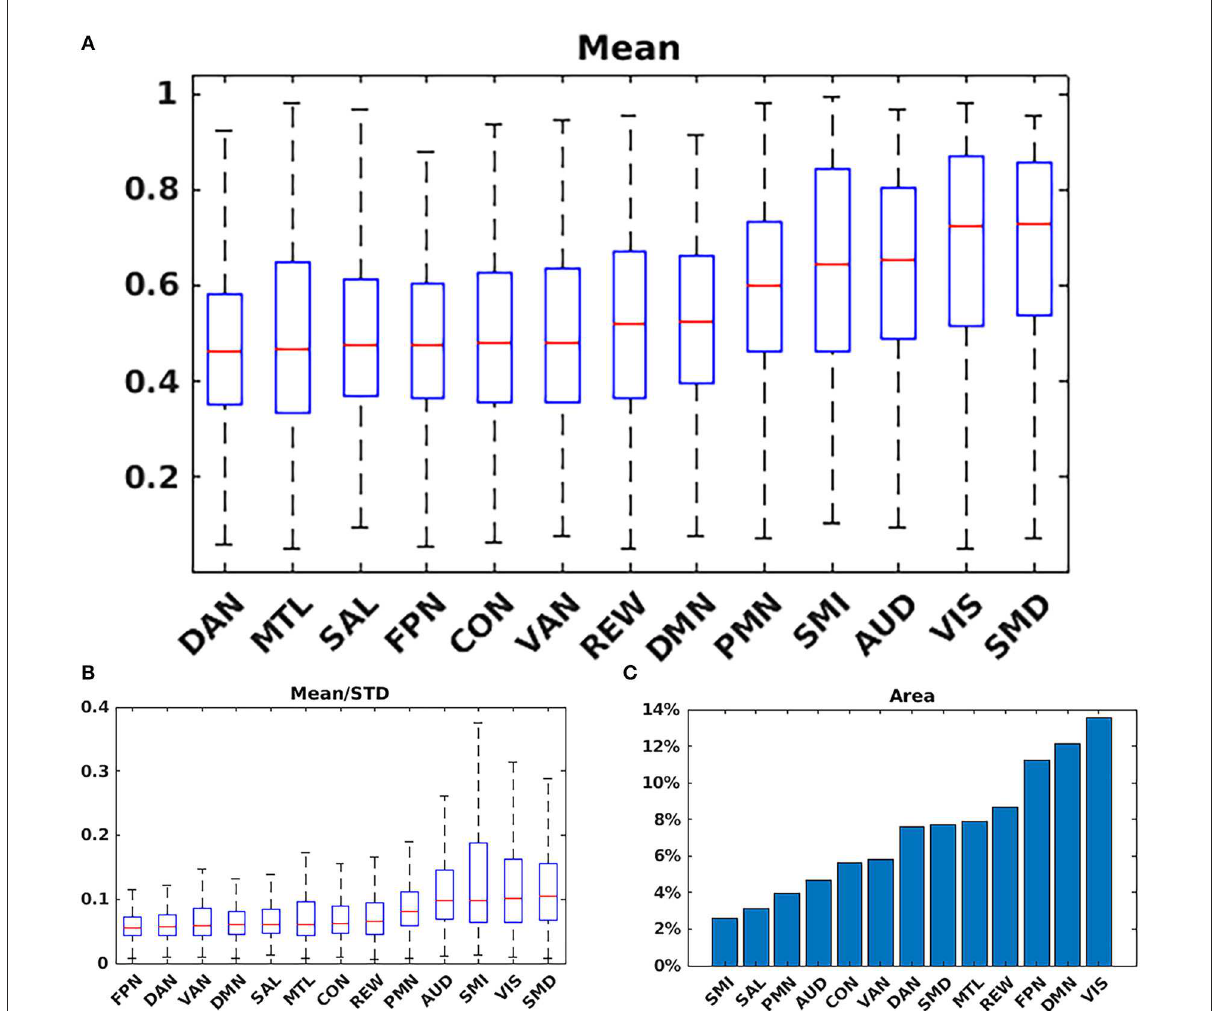
FIGURE5 Network summary measures. (A) Mean probability values averaged over each RSN based on the argmax probability (Figure 1). The highest average probabilities were observed in AUD; VIS; and somatomotor networks. (B) Average values for the mean scaled by the standard deviation. (C) Total area for each network. VIS; DMN; and FPN covered the greatest area. SMD, dorsal somatomotor; SML, lateral somatomotor; CON, cinguloopercular; AUD, auditory; DMN, default mode; PMN, parietal memory; VIS, visual; FPN, frontoparietal; SAL, salience; VAN, ventral attention; DAN, dorsal attention; MTL, medial temporal; and REW,